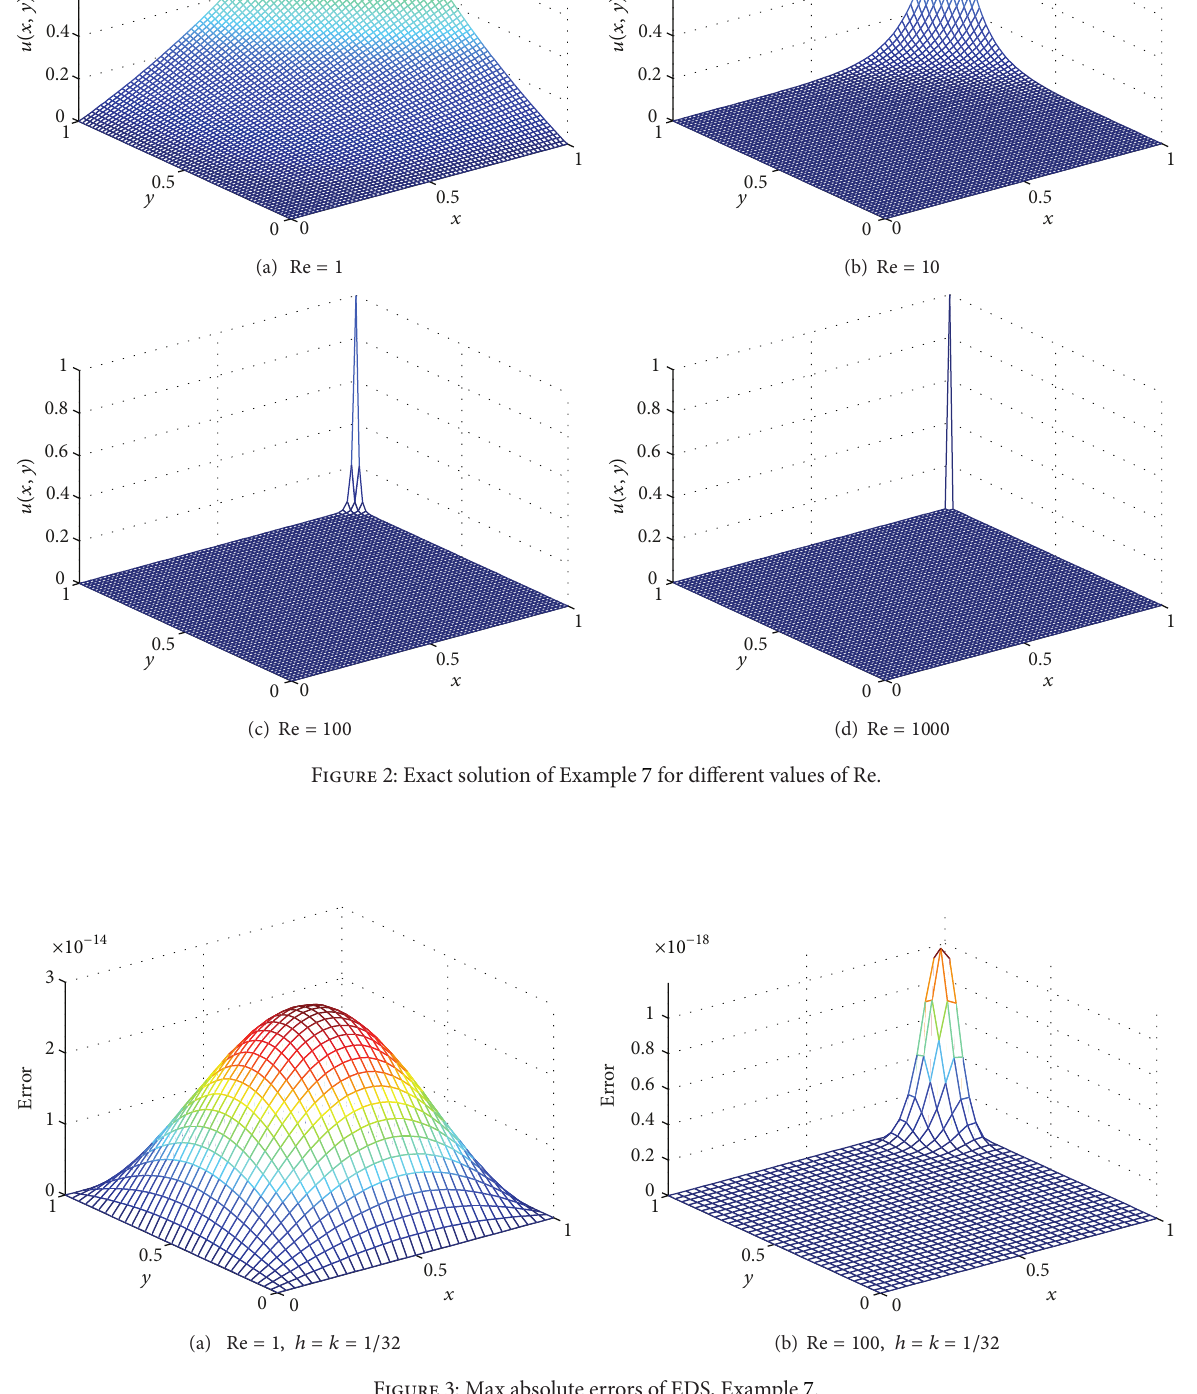
Figure 3: Max absolute errors of EDS, Example